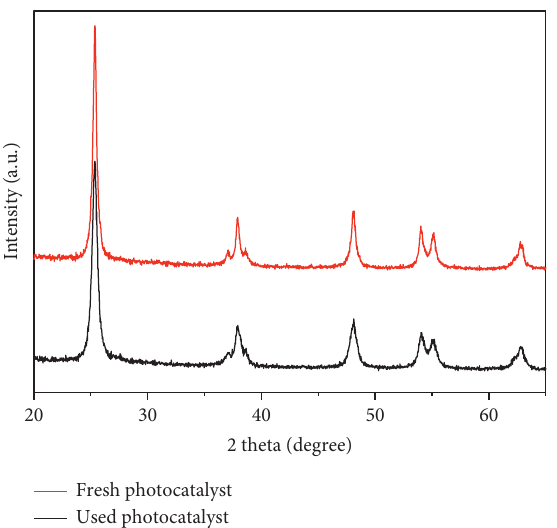
Figure 14: XRD patterns of fresh and used 2 wt% BiVO